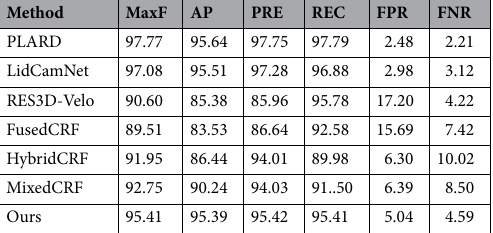
Table 4. Comparison with Several Popular Fusion-based Methods on UMM_ROAD (BEV)